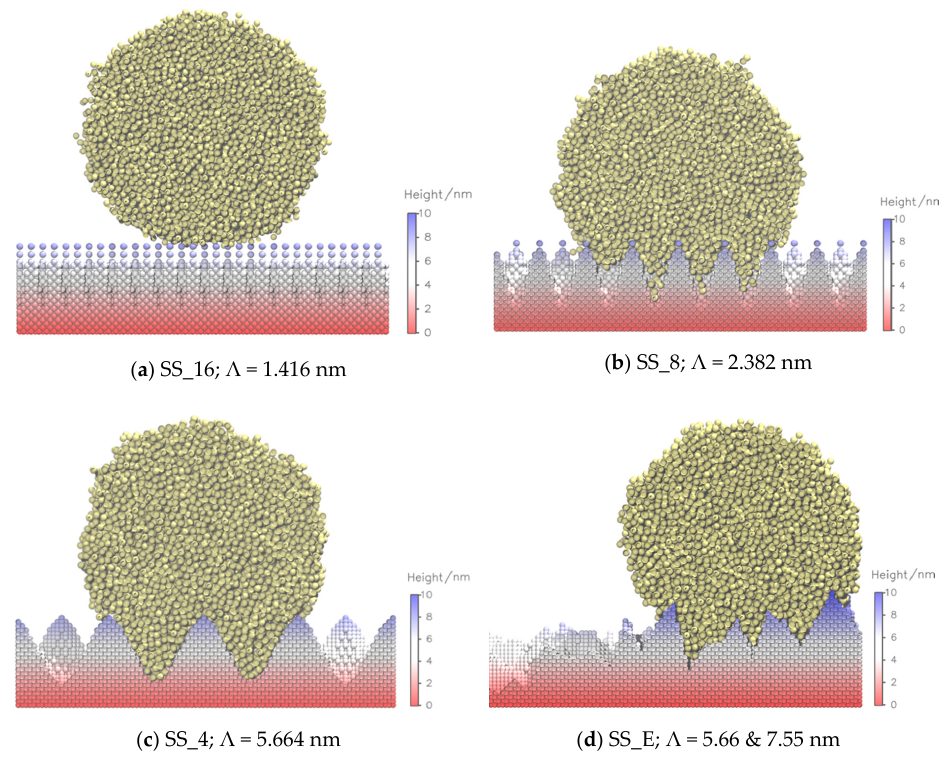
Figure 9. Longitudinal section of an equilibrated configuration showing how the fluid fills the gaps between asperities on surfaces. Presented surfaces include the sinusoidal surrogates with wavelengths ( Λ ) of ( a ) 1.416, ( b ) 2.382, and ( c ) 5.664 nm, and ( d ) the surface with Ketton topography. The di ff erent fluid configurations indicate a transition from the Cassie–Baxter state to the Wenzel state. The color of the beads indicates their elevations (in nm) in the z -direction.